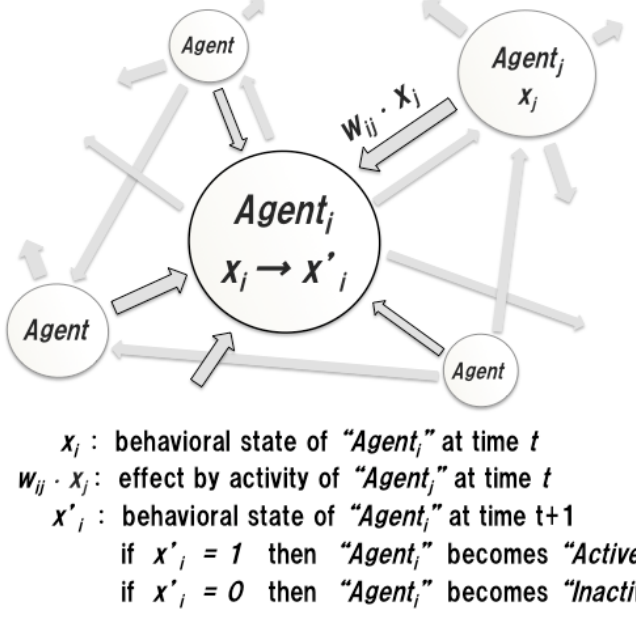
Figure 1. Model of a multiagent